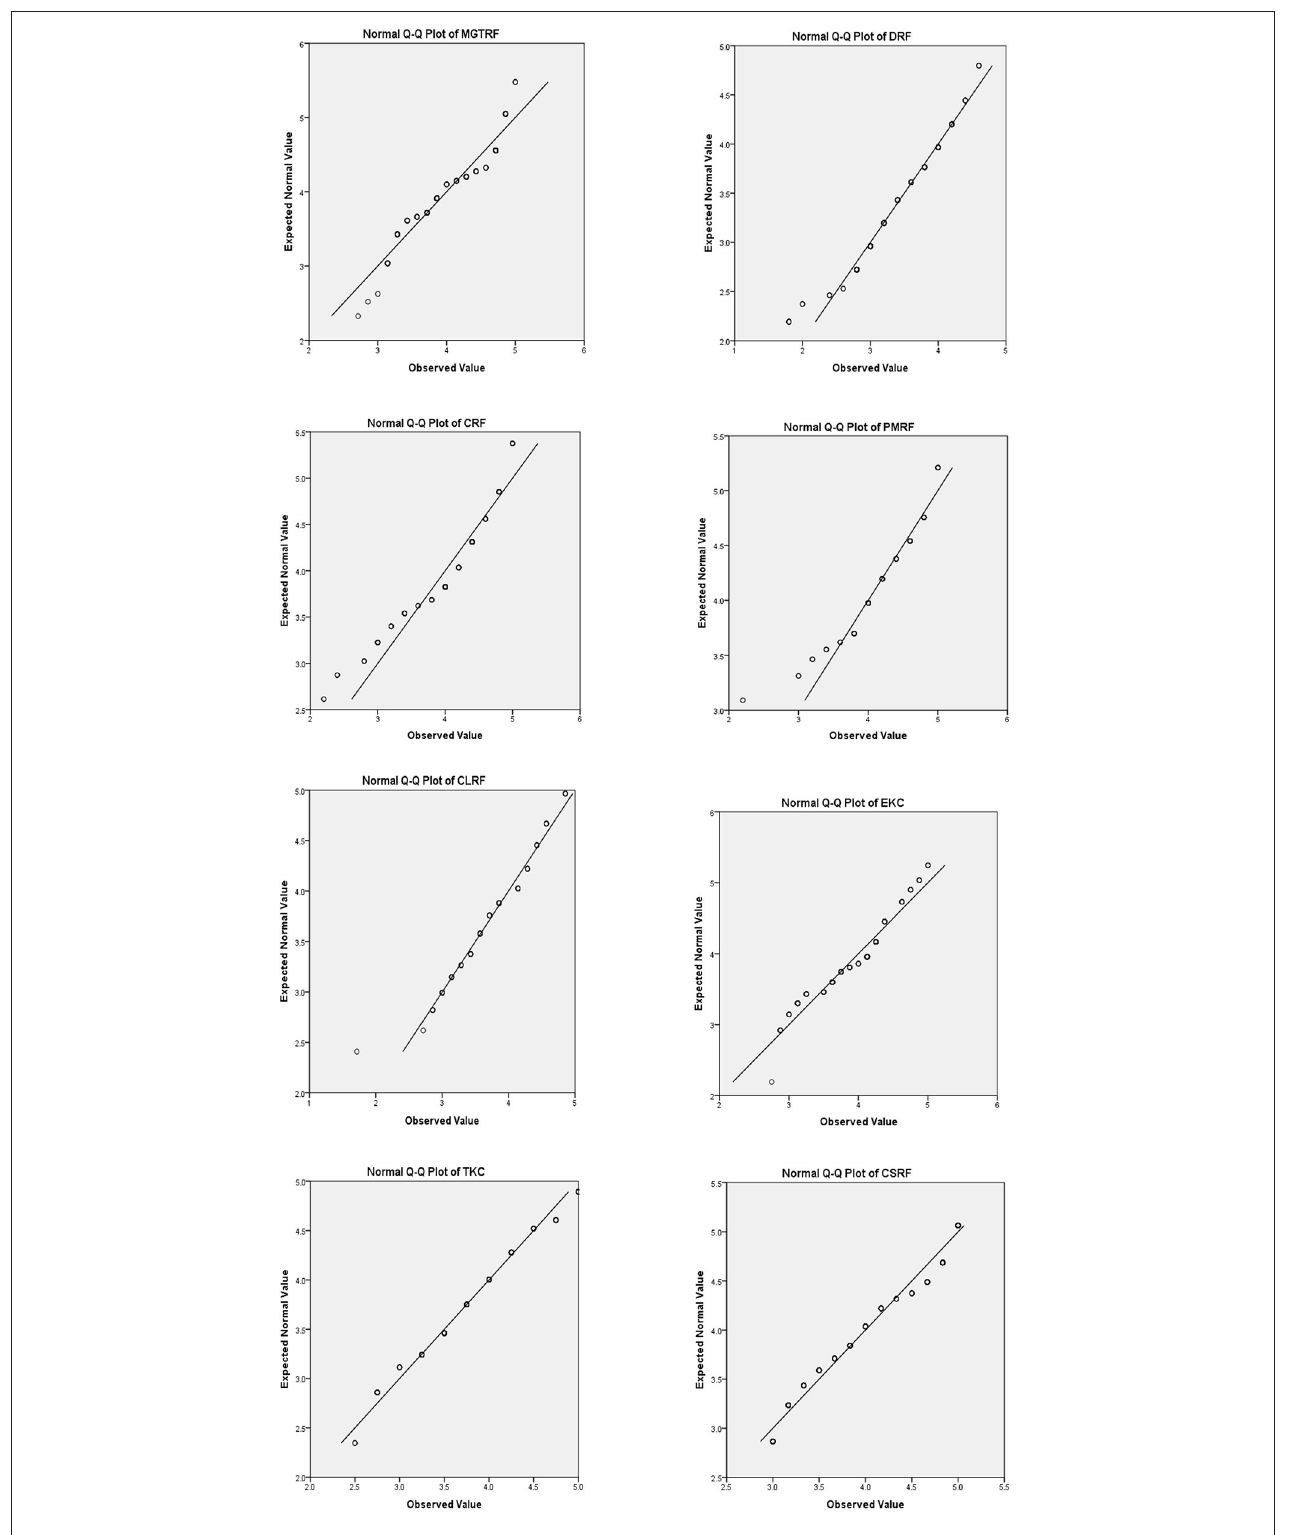
FIGURE 3 | Normality probability plots of variables. Source: Author’s constructed.